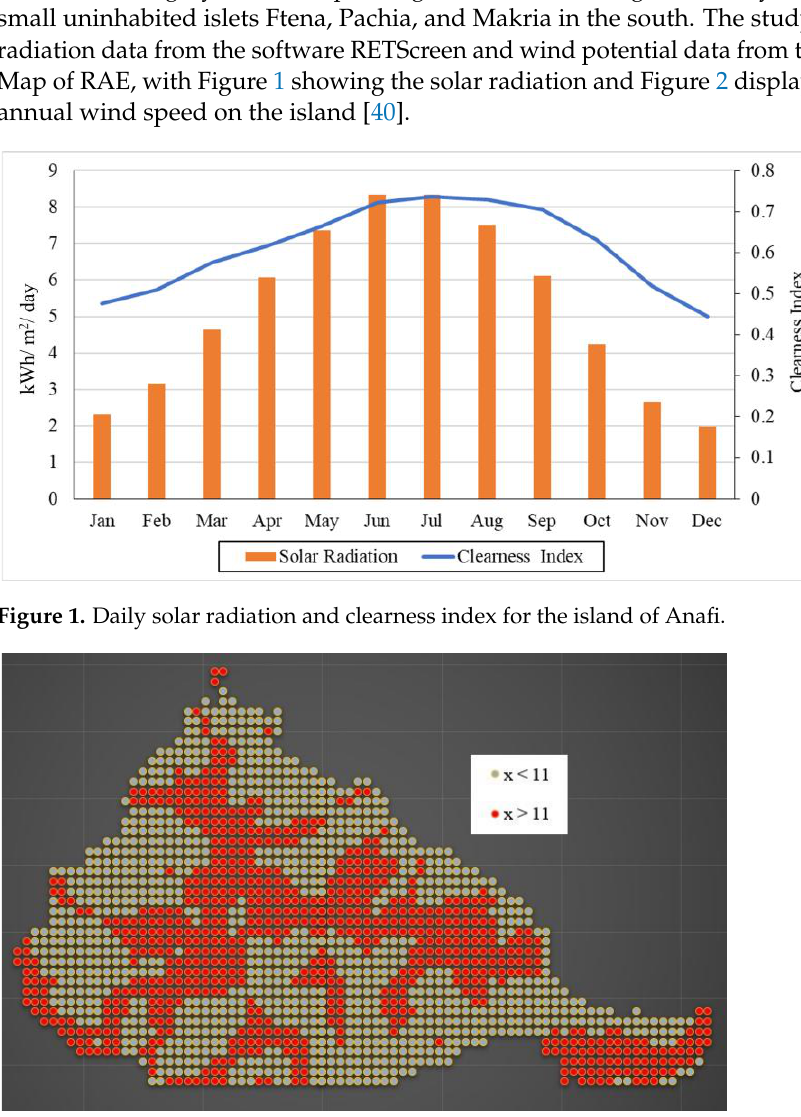
Figure 2. The areas with lower and higher average annual wind speeds for Anafi.